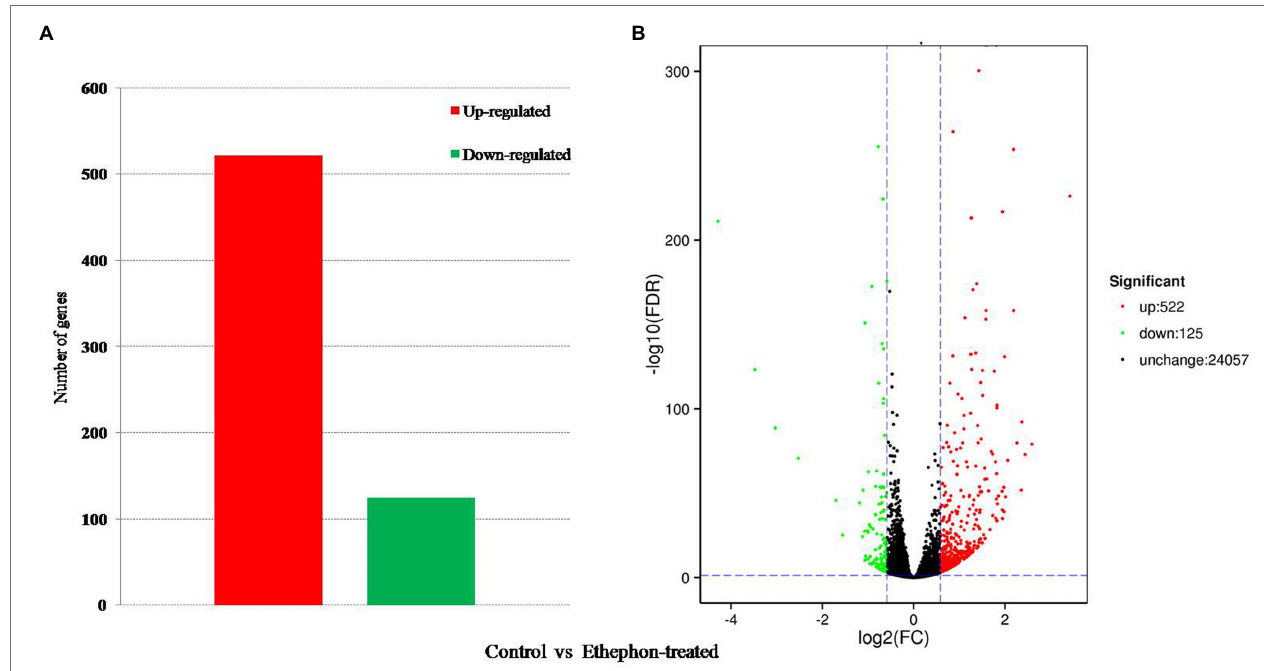
FIGURE 2 | Analysis of differentially expressed genes (DEGs) between ethephon-treated and control plants. (A) Numbers of upregulated and downregulated DEGs. Red and green colors indicate up- and downregulated transcripts, respectively. (B) Volcano map of